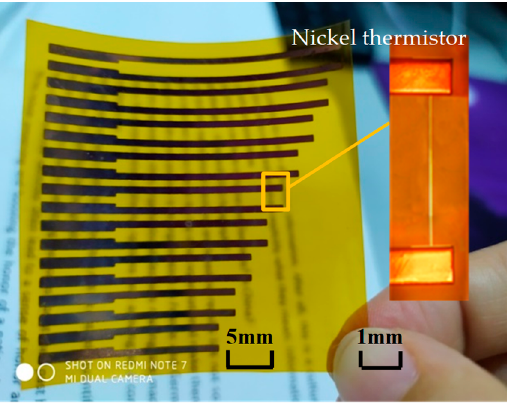
Figure 2. The sensing element of flexible hot film shear stress sensor.